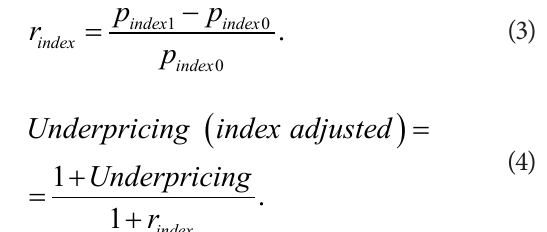
Table 1. Number of IPOs in